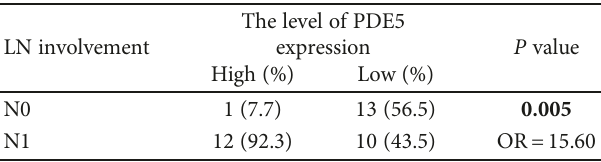
Table 3: PDE5 expression and lymph node involvement in patients aged ≥ 45